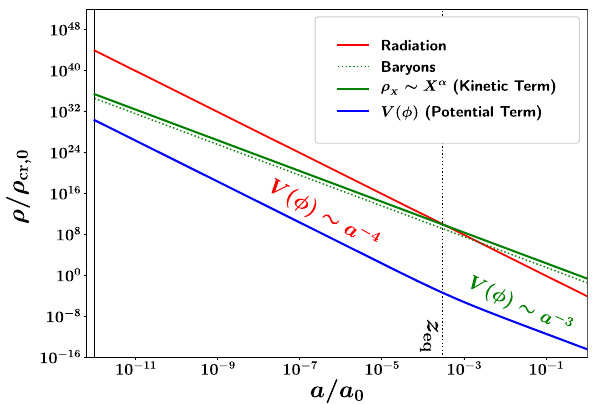
Fig. 1 This figure illustrates the evolution of the density in radiation (red curve), baryons (dotted green curve) and a non-canonical scalar field with the potential V ∝ φ − 2 . The solid green curve shows the ∝ X α which behaves like dark matter, evolution of the kinetic term ρ X ρ ∝ a − 3 . The blue curve shows the evolution of the potential V (φ) . X Note that V scales like the background fluid so that V ∝ a − 4 during the radiative regime and V ∝ a − 3 during matter domination ( α = 10 8 has been